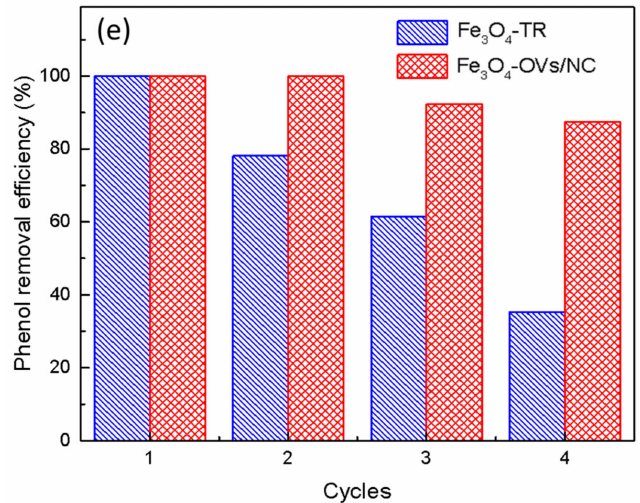
Figure 4. Effect of solution pH on the degradation of phenol catalyzed by ( a ) Fe 3 O 4 -OVs/NC and ( b ) Fe 3 O 4 -TR (0.4 g L − 1 catalyst dosage, 20 mmol L − 1 H 2 O 2 dosage). Effect of ( c ) H 2 O 2 concentration (0.4 g L − 1 catalyst dosage, pH = 3) and ( d ) catalyst dosage (20 mmol L − 1 H 2 O 2 dosage, pH = 3). ( e ) Stability and reusability of Fe 3 O 4 -OVs/NC and Fe 3 O 4 -TR after each Fenton